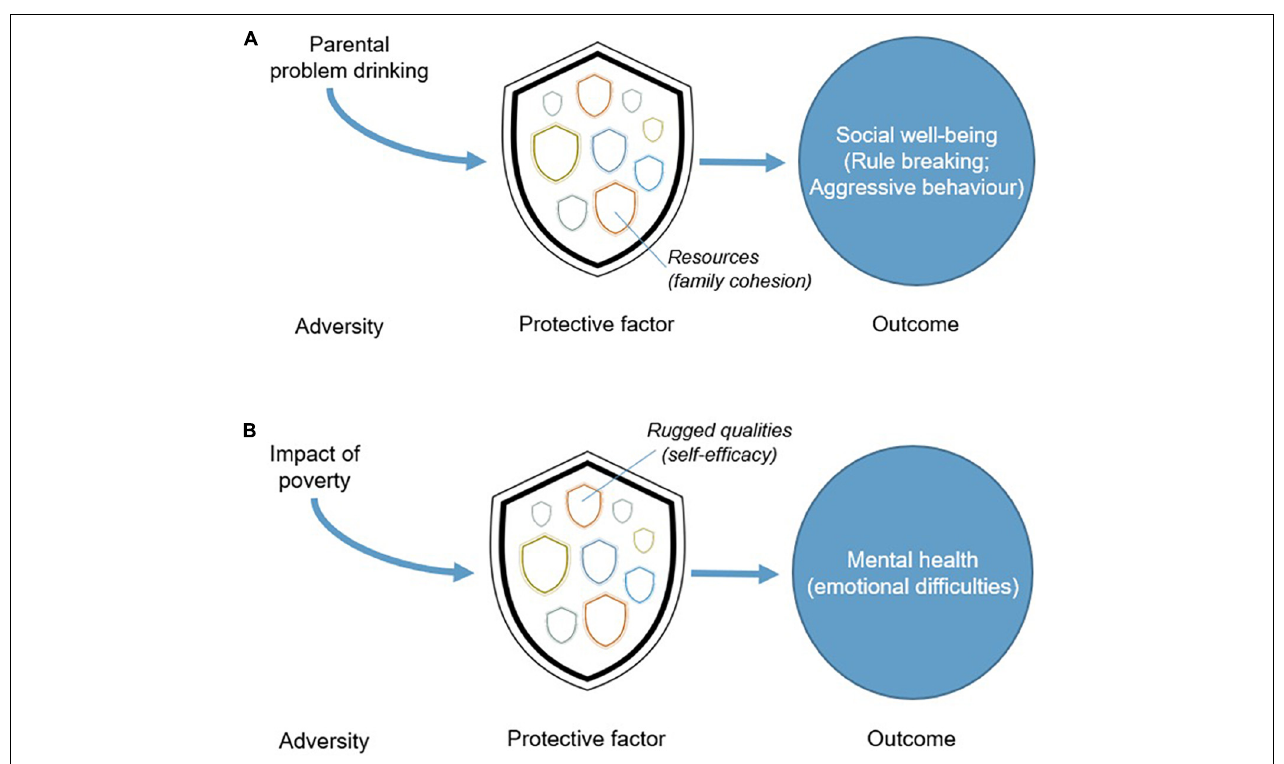
FIGURE 1 | (A,B) Connections between adversity, protective factors, and